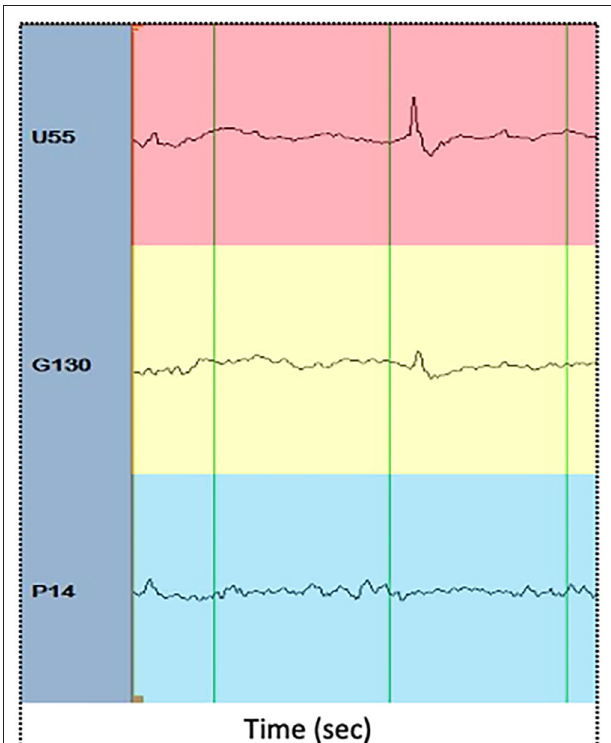
FIGURE 2 | Illustrative examples of IEDs as recorded in the focus area (red), propagation area (yellow), and silent area (blue). The x axis displays time (in seconds). Green vertical lines are spaced one second